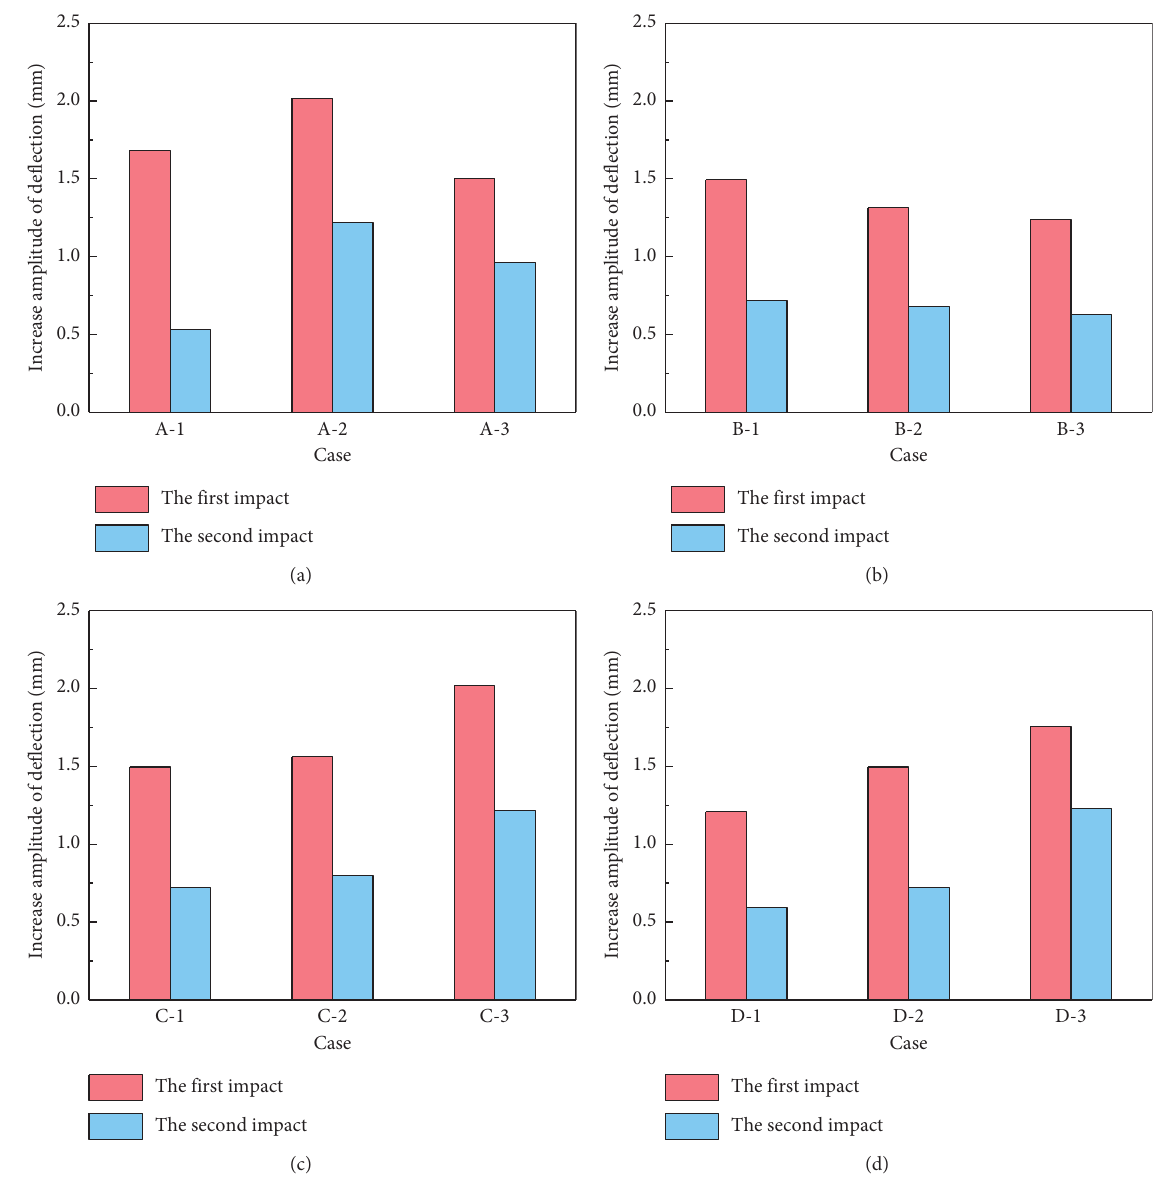
Figure 11: Comparison of deflection’s increase amplitude by two impact